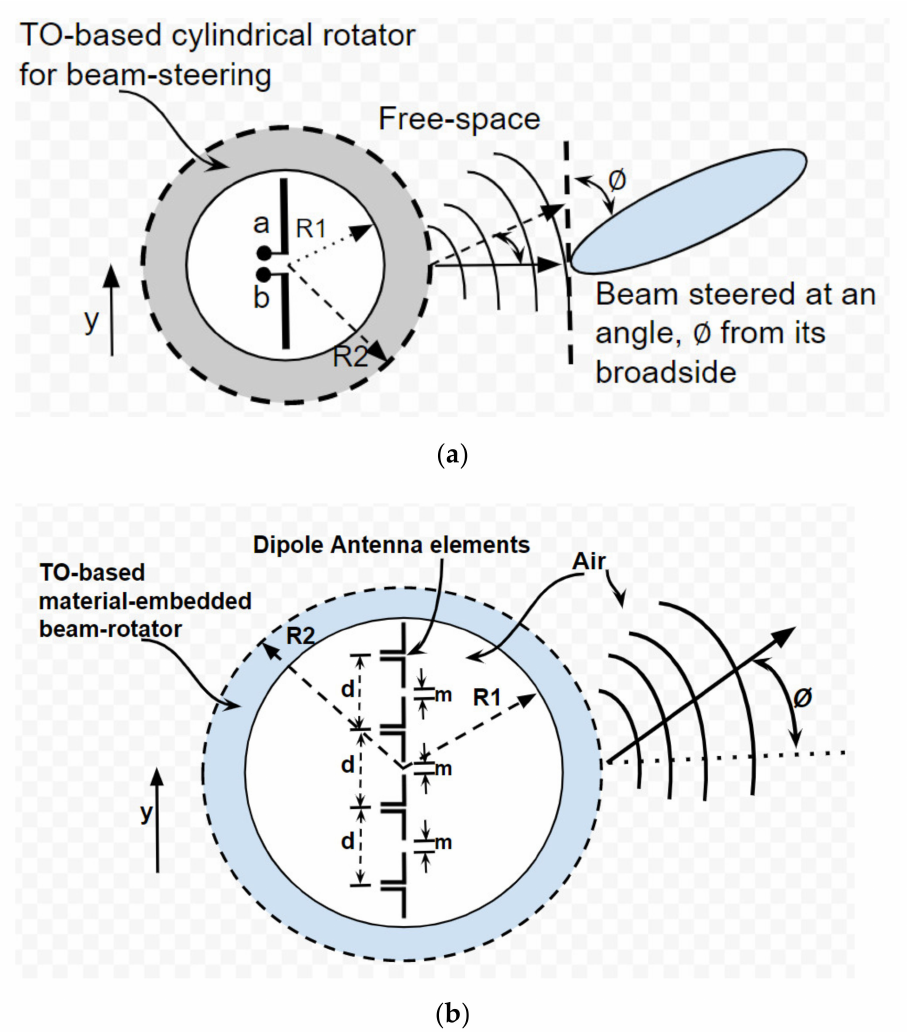
Figure 2. Metamaterial based cylindrical beam-steerer using TO: ( a ) Proposed TO-based cylindrical beam-steerer enclosing a single dipole element. ( b ) Material-embedded cylindrical beam-steerer using TO enclosing a co-linear vertical dipole